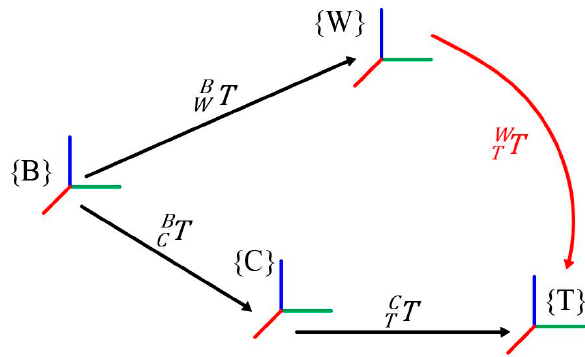
Figure 3. Coordinate frame transformation during the attachment changing process.